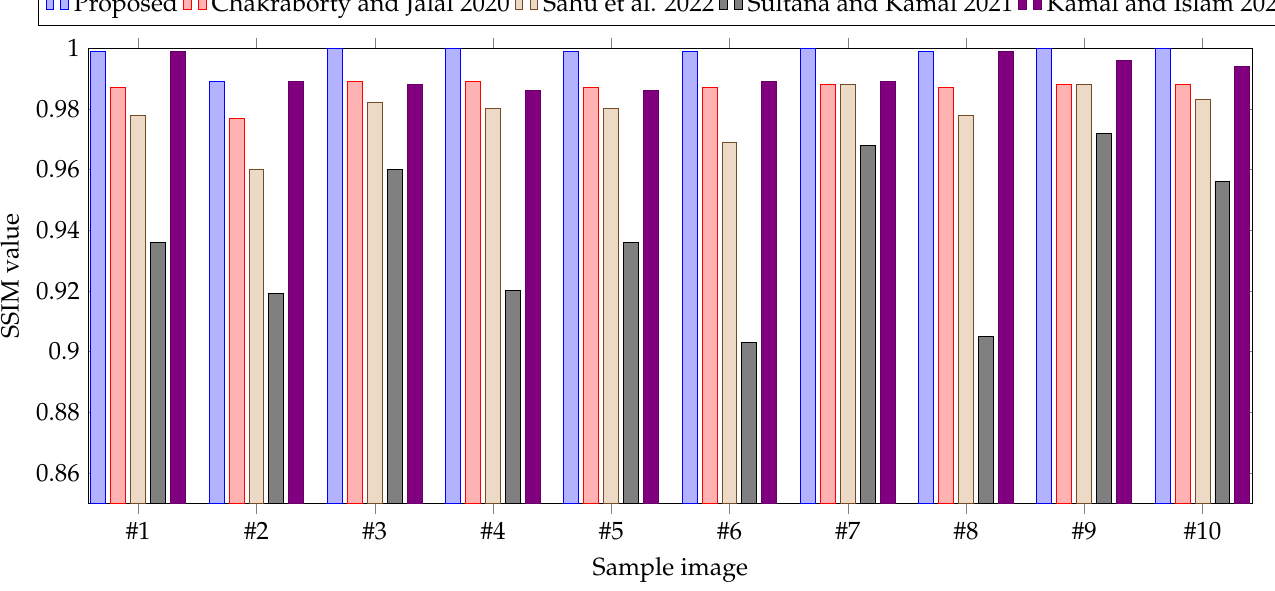
Figure 8. Comparing SSIM of different images in different schemes. The figure states that the proposed scheme has the highest SSIM value